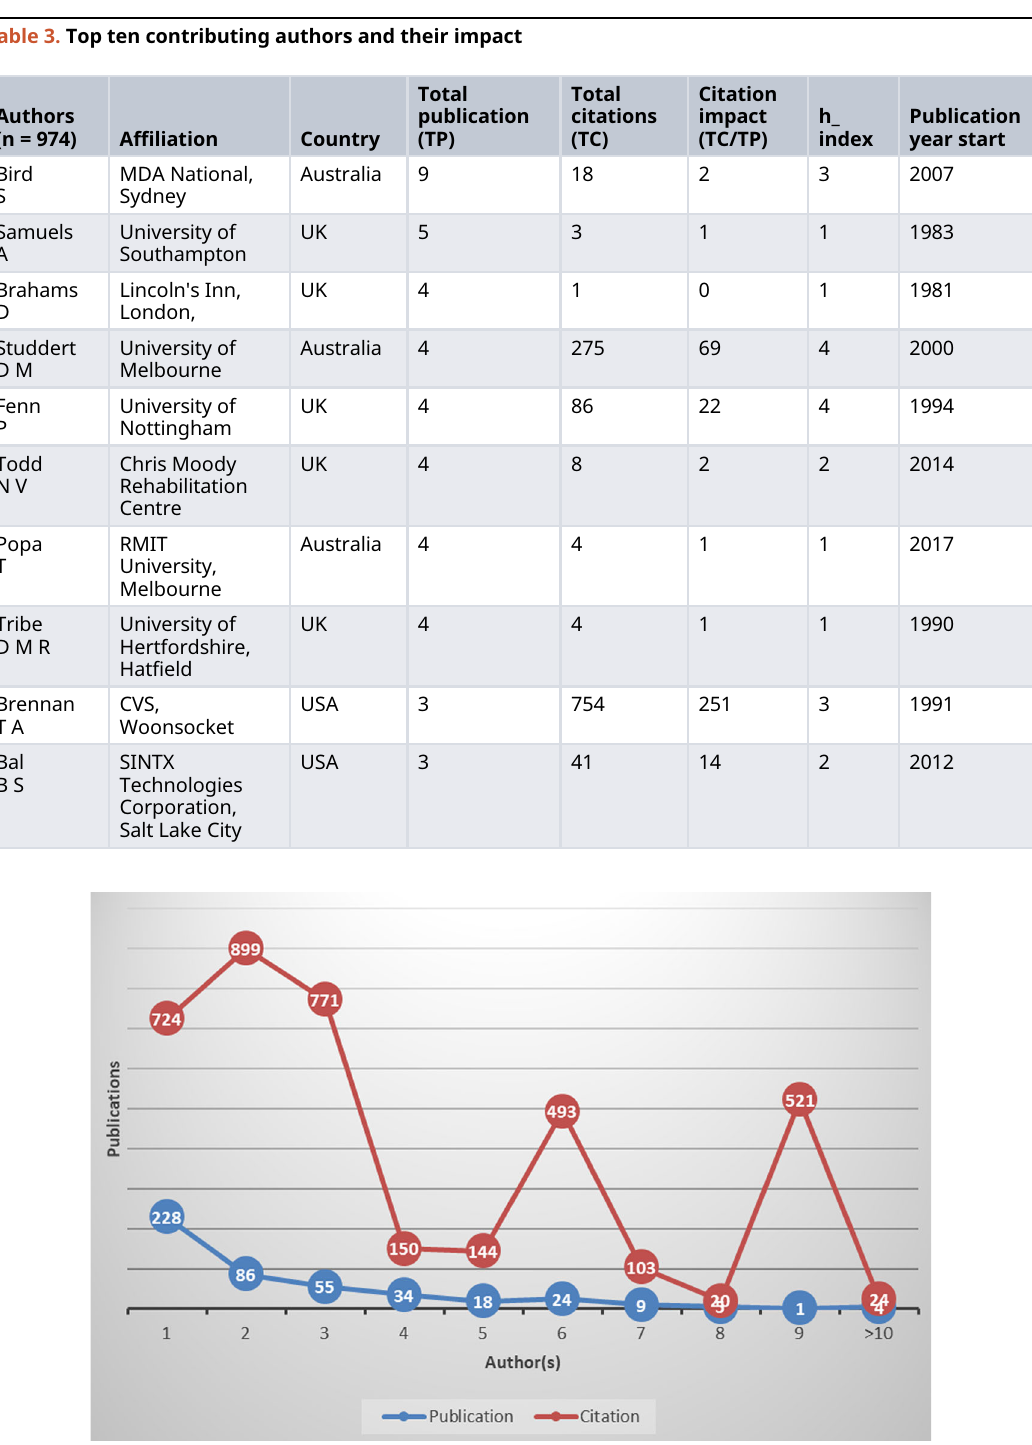
Figure 1. Authorship and collaboration